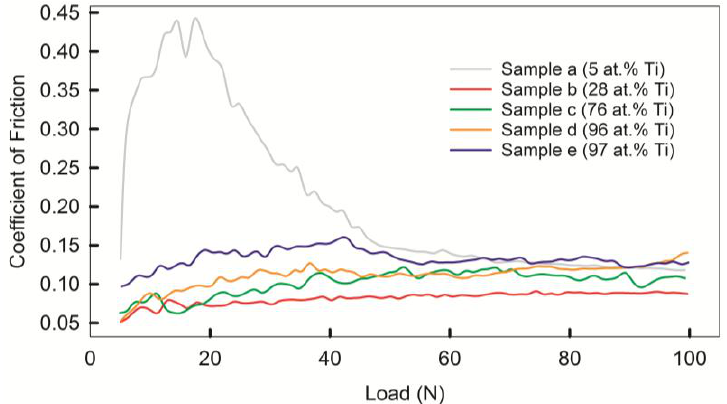
Figure 4. Friction coefficient vs. load applied for Ti-MoS 2 coatings on five samples (a–e). Tests conducted by scratch test using fixed chrome steel ball with 5 mm diameter ball sliding against a coated sample. Progressive load 5–100 N applied with 50 N/mm loading rate.